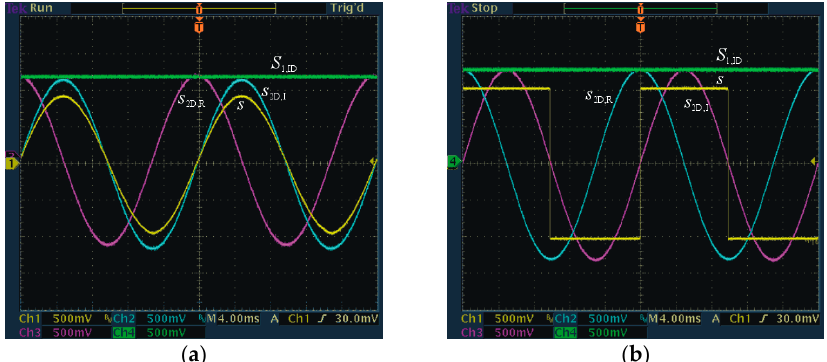
ωω ≈ and the input signal is, ( a ) sine wave and ( b ) 2D,0 s